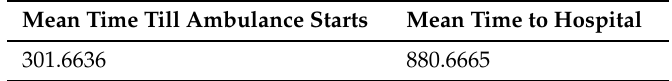
Table A2. The result of the query “Priority 1 Mean Response Times”. Values are in seconds.